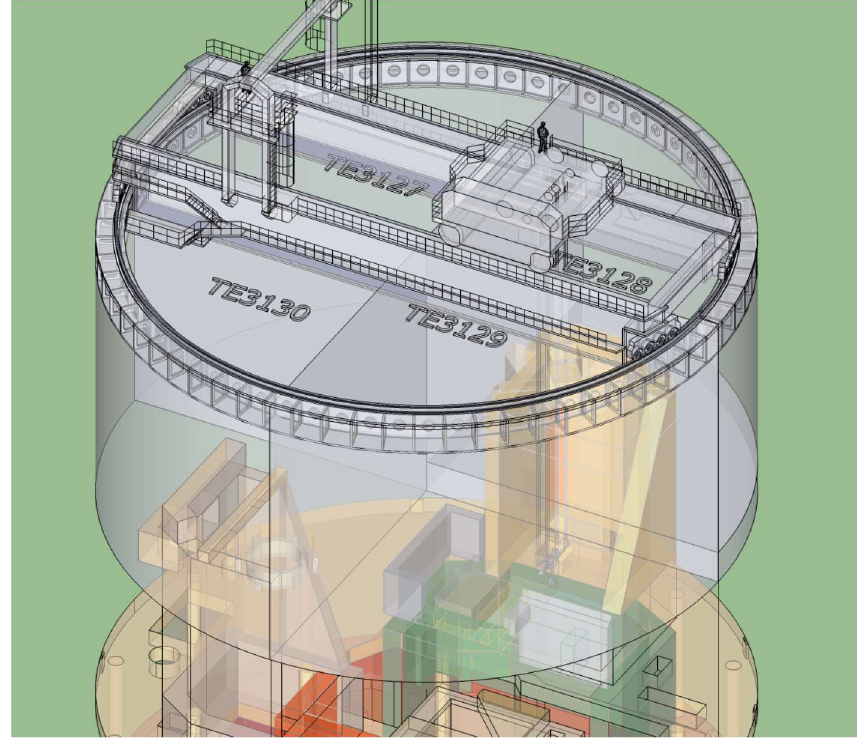
Figure 9. Subdivision of the upper containment part in the volumes for each instrumented location (volume weighting factors).